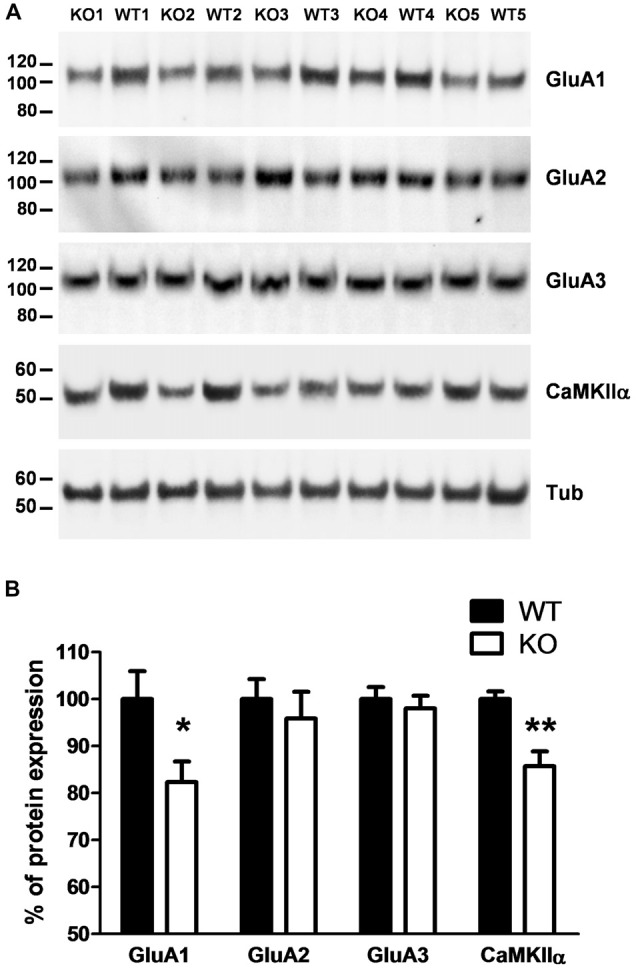
PROT−/− mice show altered expression of synaptic proteins in cortex. (A) Western blot analysis of cortex crude synaptomes (P2) prepared from WT and PROT−/− (KO) animals. Equal amounts of protein (20 μg/lane) were loaded and probed with the indicated antisera. (B) Quantitative analysis of the immunoreactive bands corrected by β-tubulin (n = 12 mice for each genotype; *p < 0.05; **p < 0.01; two-tailed Student’s t test). Data are shown as means ± SEM.